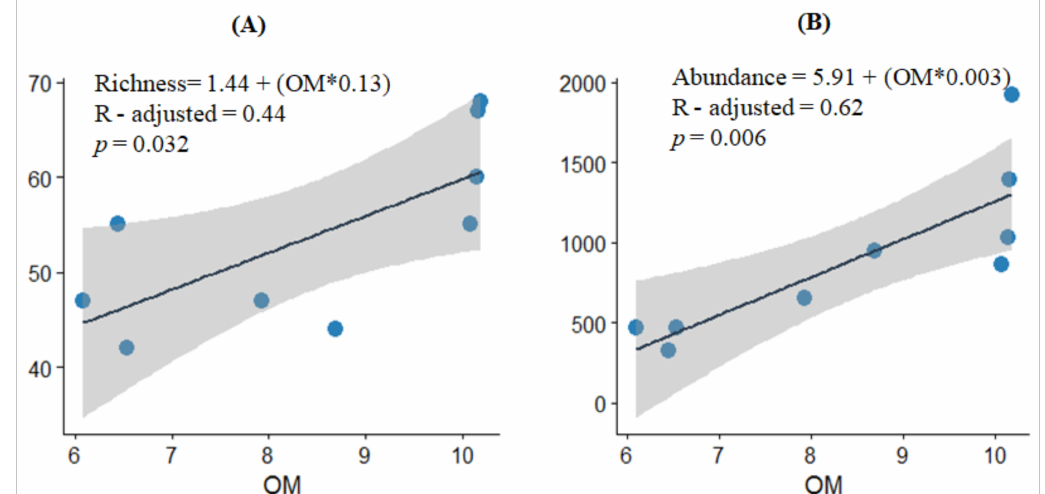
Figure 5. Linear regression models of observed and predicted values of macrofungal richness ( A ) and abundance ( B ) of young, middle aged, and mature Pinus radiata stands in Menagesha Suba, central Showa, Oromia National Regional State, Ethiopia. Blue circles represent the observed values of organic matter (OM), black lines indicate the line fit plots, and the shaded areas indicate the 95% confidence intervals.